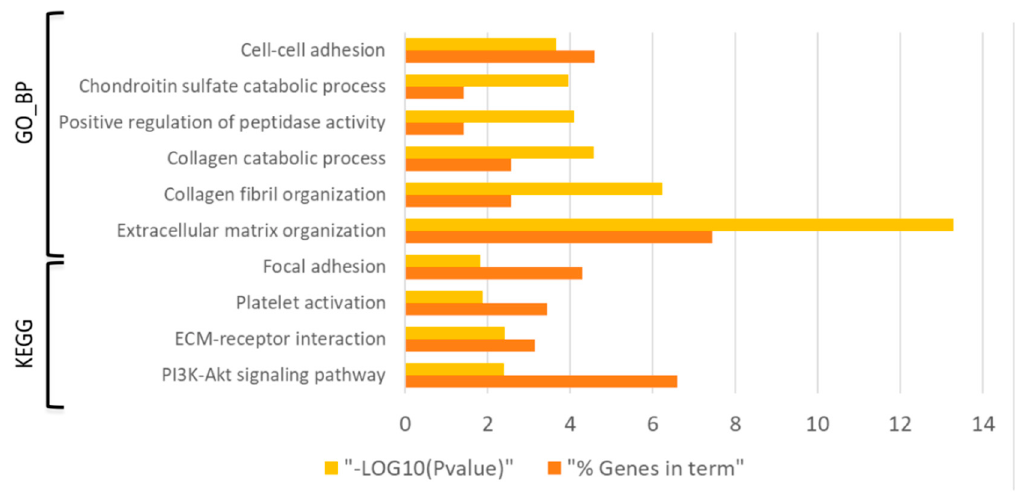
Figure 2. Bar graph showing the dysregulated Gene Ontology biological processes (GO_BPs) and KEGG pathways (FDR < 0.05) with the lowest p ‐ value ( p ˂ 0.01) in the diabetes induction process (D0 vs C0 comparison). Yellow bars indicate the p ‐ value of the term in log form and orange bars indicate the percentage of dysregulated genes in each term.